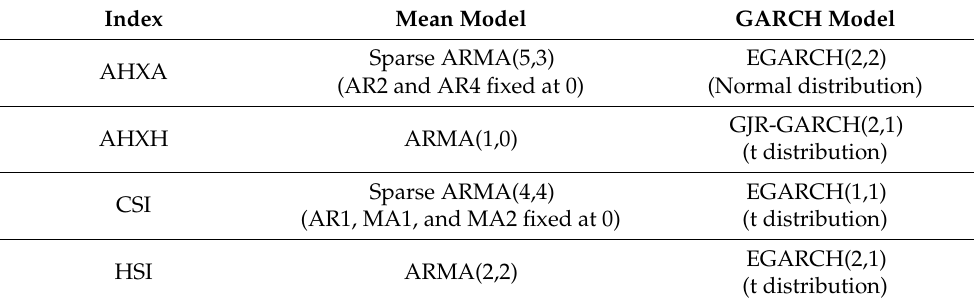
Table 1. Best ARMA-GARCH models for fitting log-return